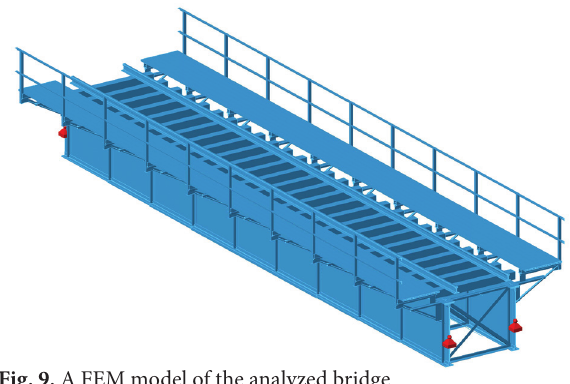
Fig. 9. A FEM model of the analyzed